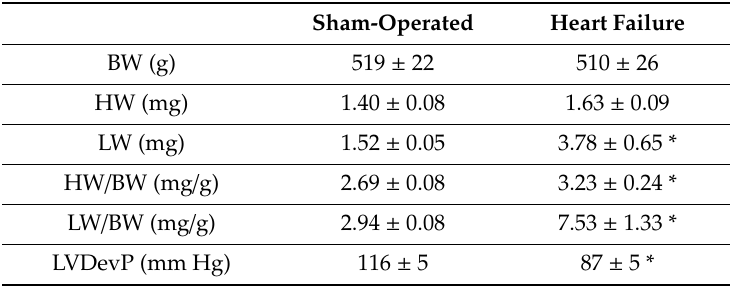
Table 1. Weight parameters and left ventricular function of sham-operated and failing